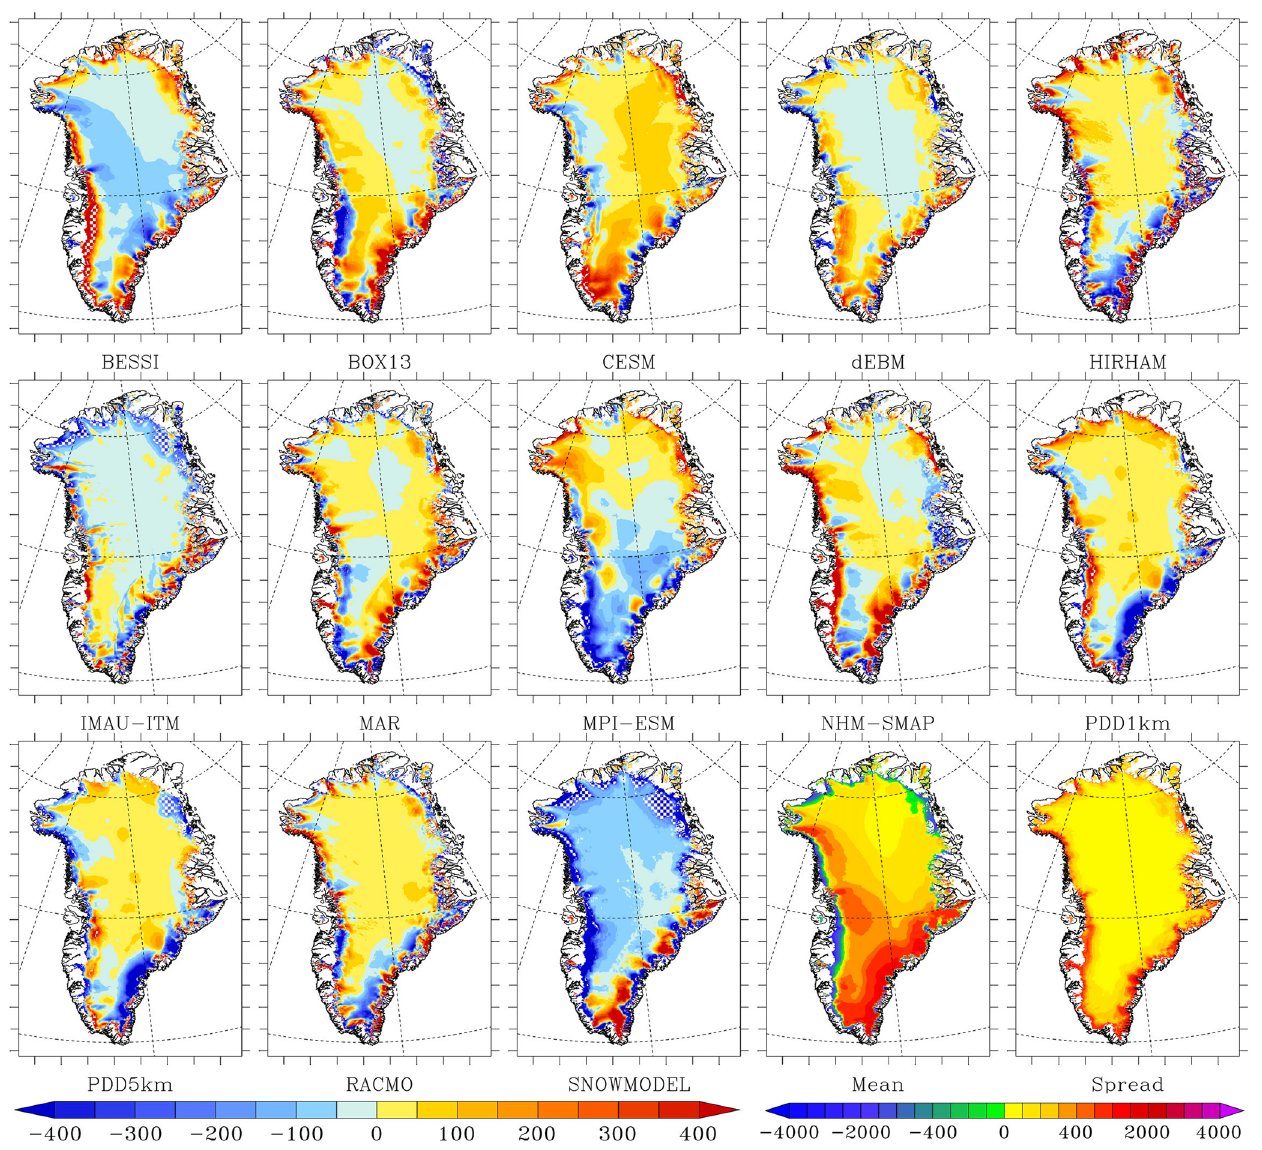
Figure 2. Same as Fig. 1 but for the modelled SMB vs. the ensemble model mean over 1980–2012 (shown in the last two plots). As in Fig. 1, the areas listed in Table 4 where SMB disagrees with the MODIS-derived bare ice area are shown in a hatched